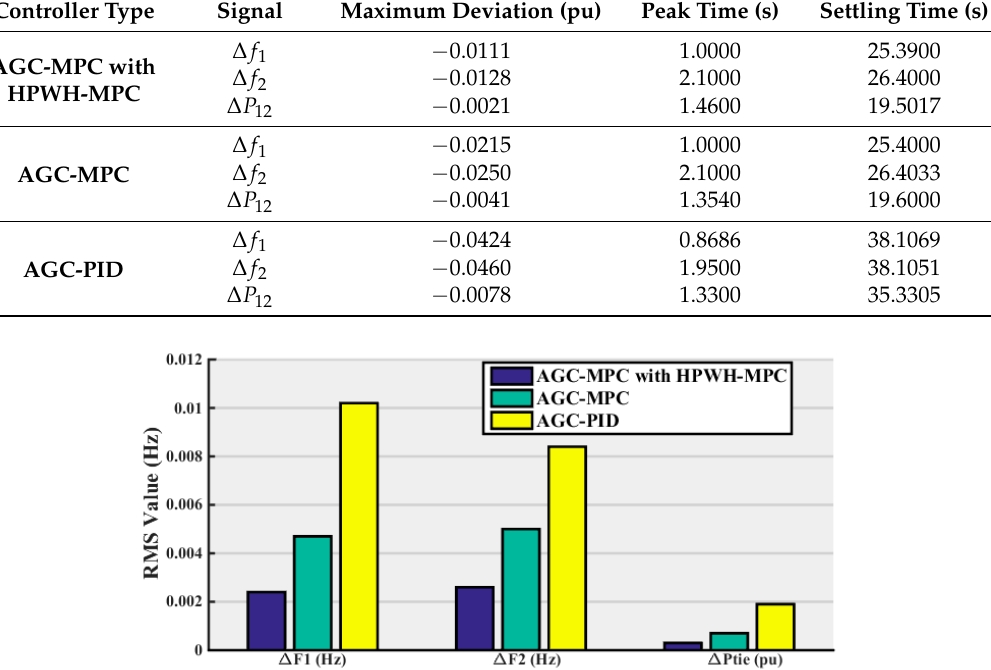
Table 5. Peak overshoot, peak time and settling time for the controllers in the third scenario.